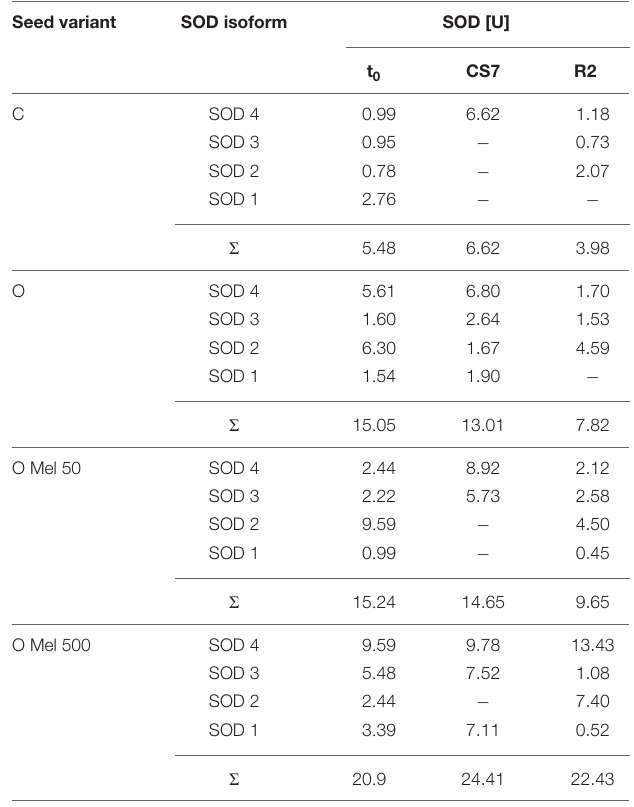
TABLE 1 | Superoxide dismutase (SOD) isoform activities estimated by densitometric analysis of the native gels (QuantityOne - BioRad). Seed